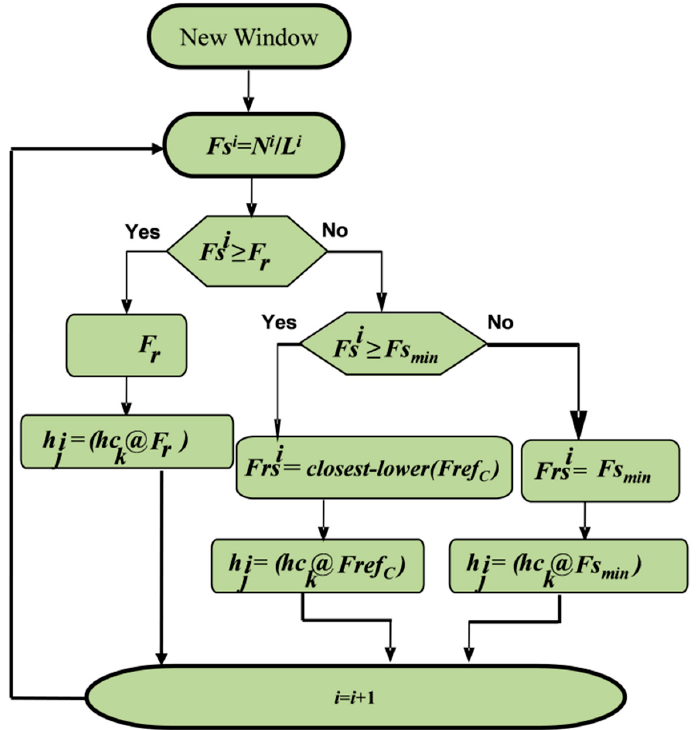
Figure 4. The process of selecting the resampling frequency and the filter coefficients from the reference filter bank for the i th selected segment.